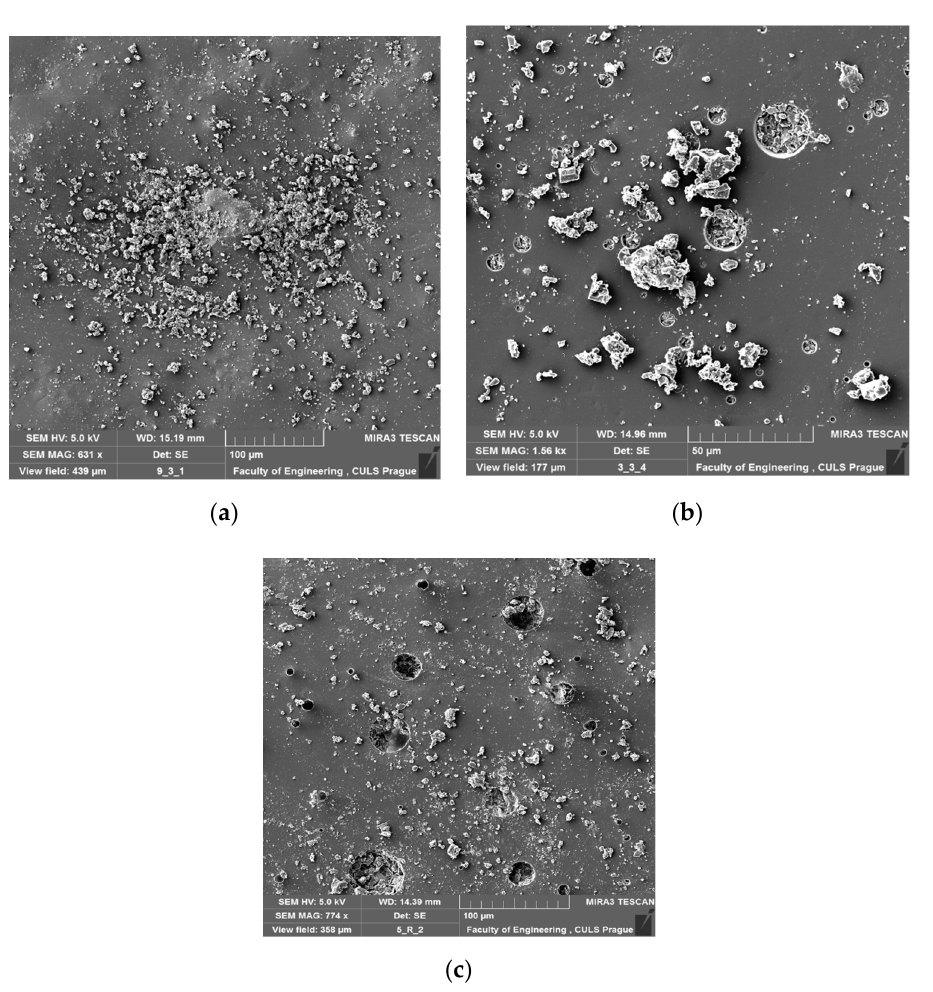
Figure 2. SEM images of modified epoxy compounds after curing process: ( a ) and ( b ) E57 / PAC / 100:80 / CaCO 3 / 2%, ( c ) E57 / PAC / C / 2%.